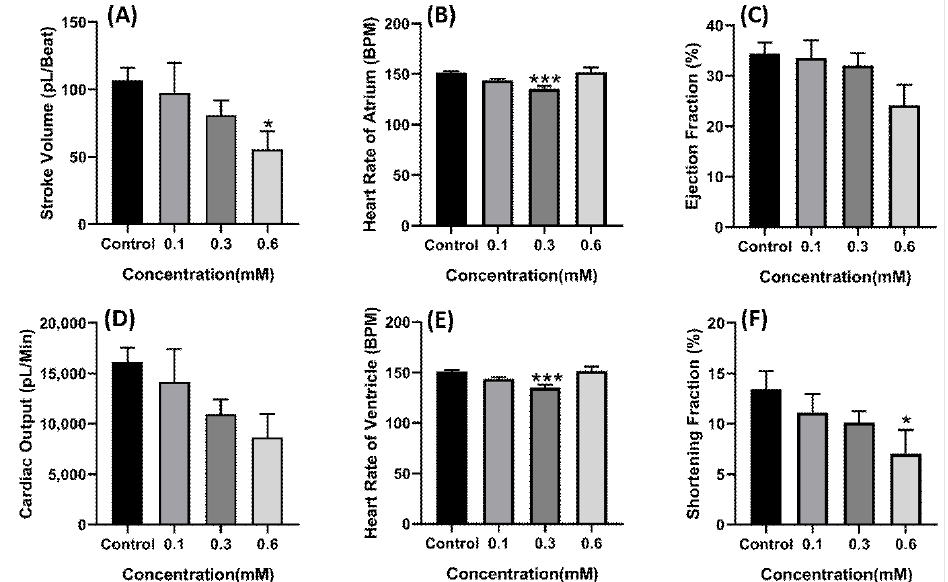
Figure 3. Cardiac physiology alteration induced by CuO nanoparticle exposure in zebrafish larvae. ( A ) Stroke volume. ( B ) Heart rate of atrium. ( C ) Ejection fraction. ( D ) Cardiac output. ( E ) Heart rate of ventricle. ( F ) Shortening fraction. Data were statistically analyzed using ordinary one-way ANOVA with the Dunnett post-hoc test for multiple comparisons. * p < 0.05, *** p < 0.001.